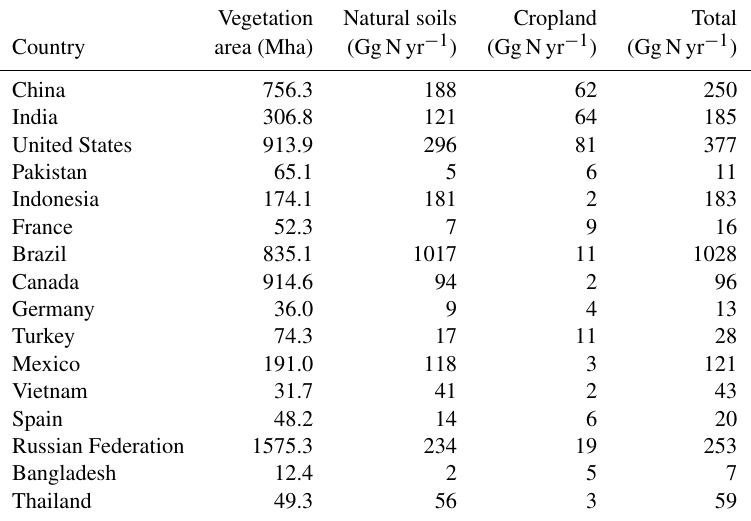
Table 1. Preindustrial N 2 O emissions from natural vegetation and croplands in different countries. 1Mha = 10 4 km 2 . Vegetation Natural soils Cropland Total Country area (Mha) China India